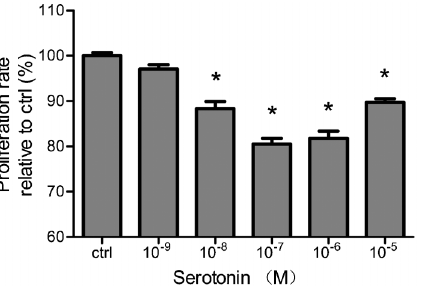
Figure 1. Serotonin inhibited proliferation of primary osteoblasts. Growth of osteoblasts treated with serotonin (1 nM-10 m M) was inhibited compared to controls. This influence was alleviated in the 10 m M and 1 m M groups (relatively high concentrations). Data are reported as means±SE. *P , 0.05 vs control (ctrl) group (Dunnett test).